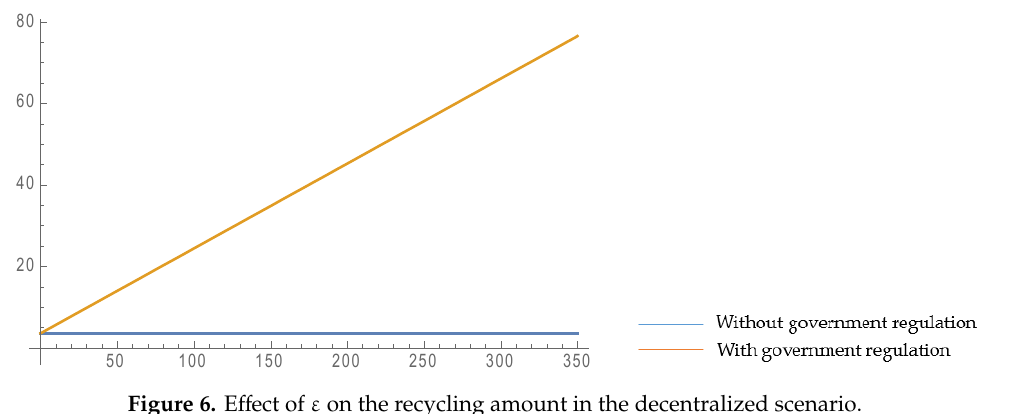
Figure 5. Effects of  and q 0 on the total profits in CLSC.